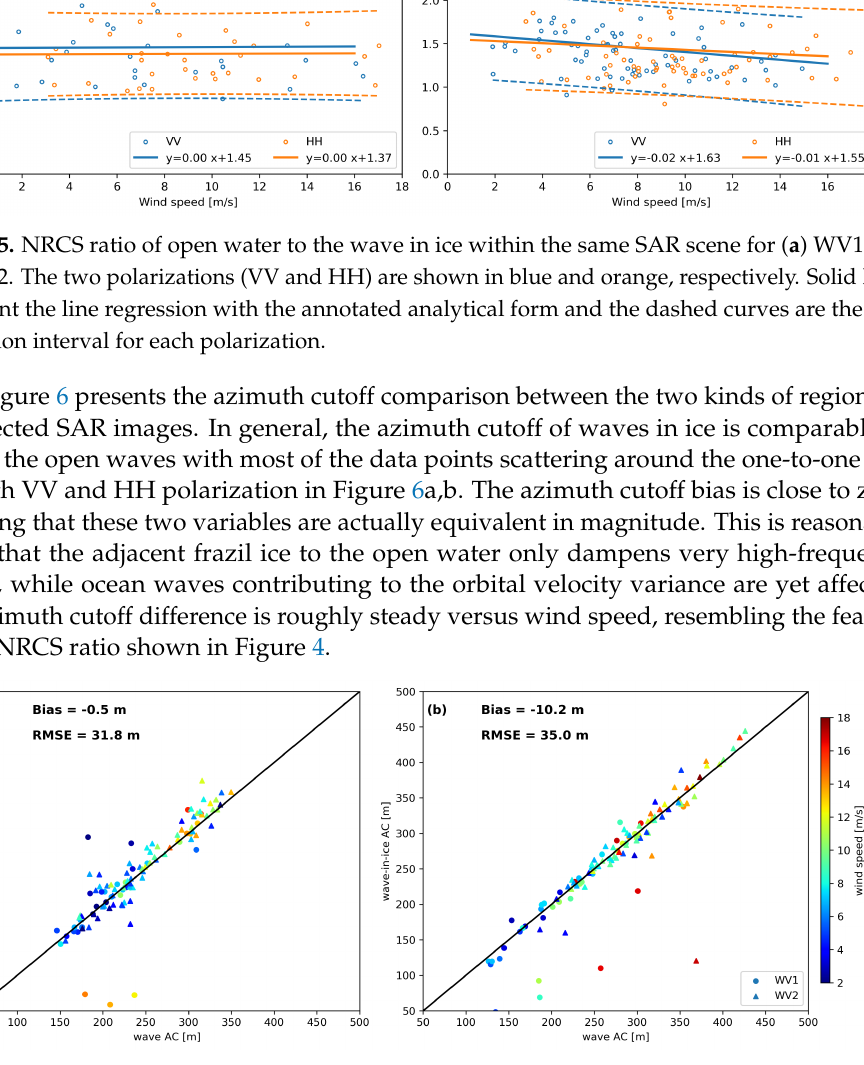
Figure 6. SAR azimuth cutoff of wave in ice versus the open water is shown for ( a ) VV and ( b ) HH polarization. Color denotes the wind